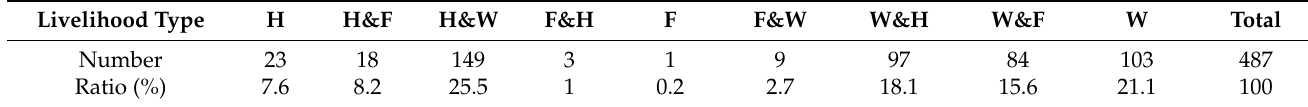
Table 3. Number of livelihood type surveyed in the